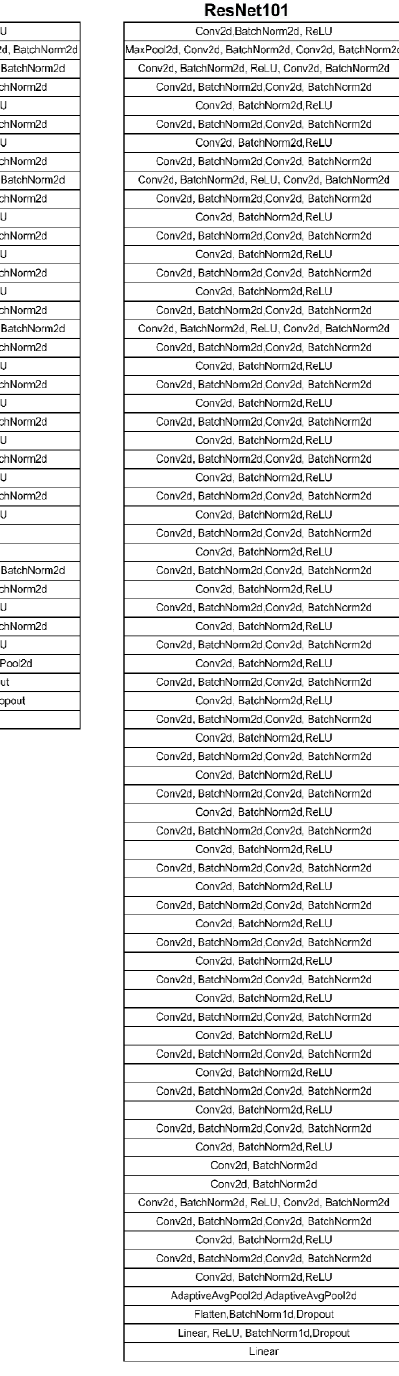
Figure 6. Transfer learning architectures.